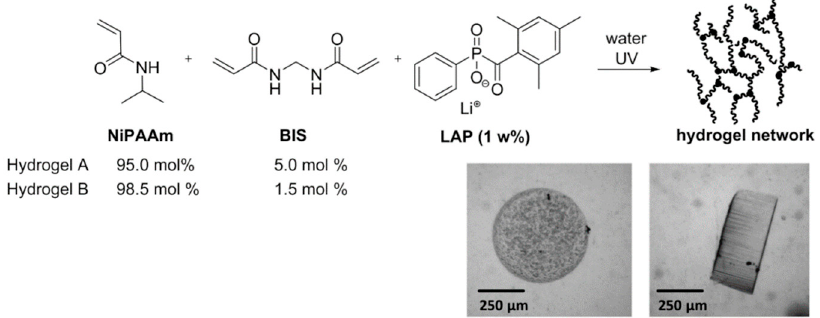
Figure 5. Synthesis of PNiPAAm hydrogels with BIS as a crosslinker. Microscope images show a photopolymerized cylinder of hydrogel A in the swollen state in top ( left ) and side view ( right ).